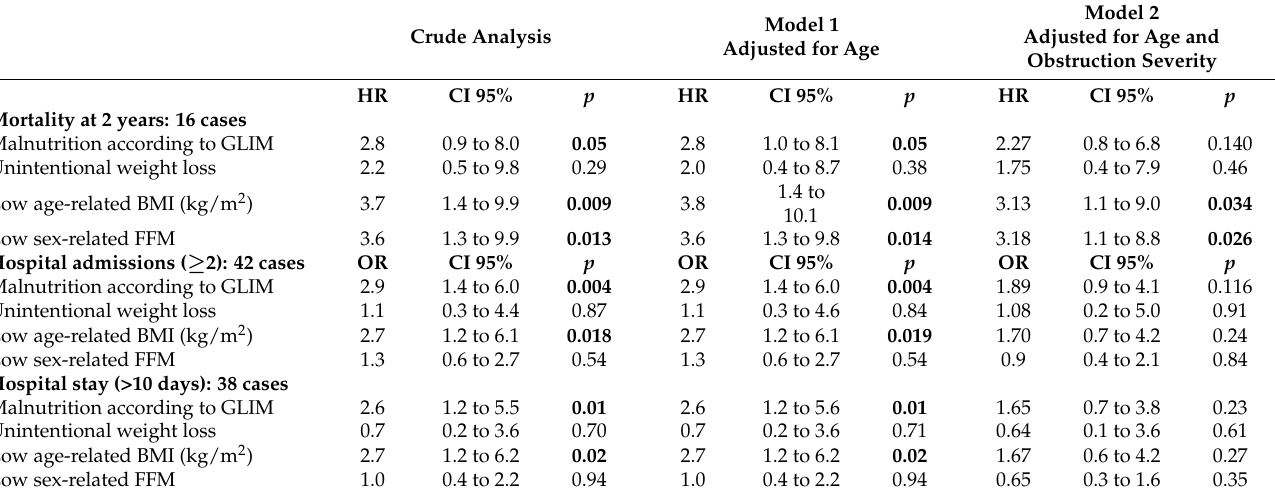
Table 4. Hazard ratios of mortality and odds ratios of admissions and length of stay in 2-year follow-up according to malnutrition as defined by the GLIM consensus and separately by its specific phenotypic criteria. Crude analysis and adjusted results ( n =